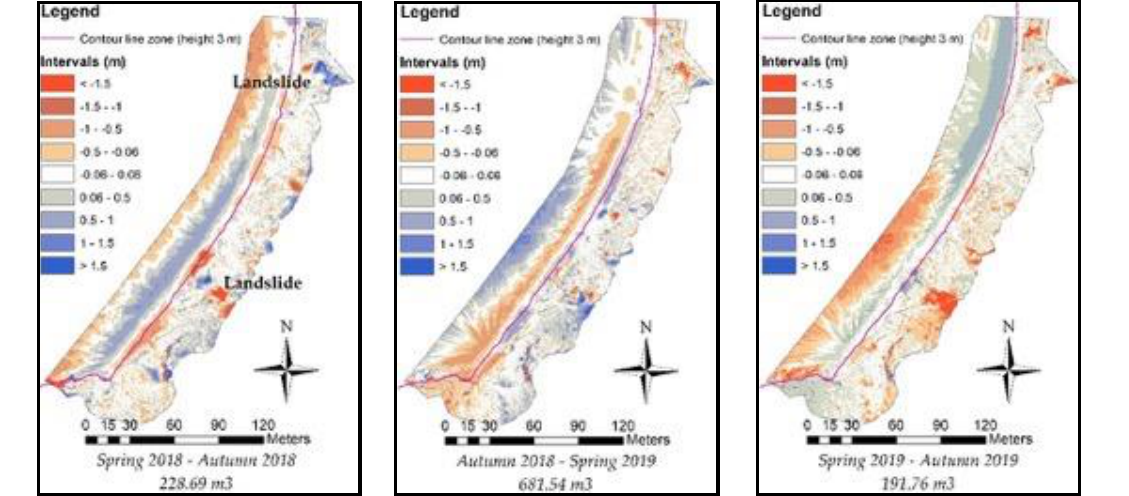
Figure 9. Volumetric evolution between the spring of 2012 and the fall of 2019.